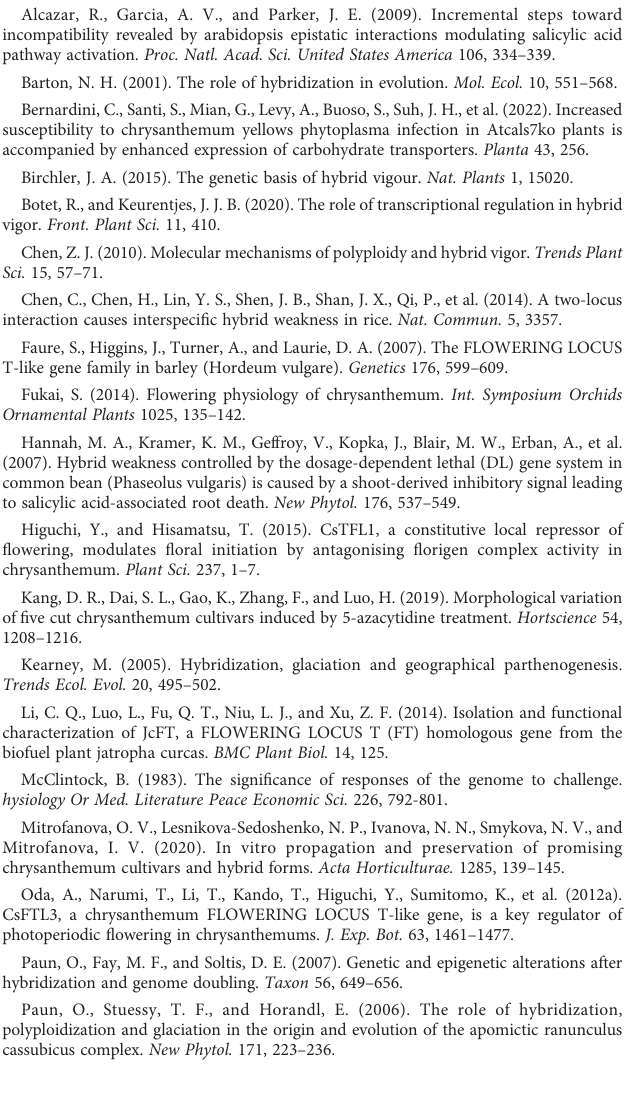
SUPPLEMENTARY FIGURE 1 Flowering time of the hybrid and their